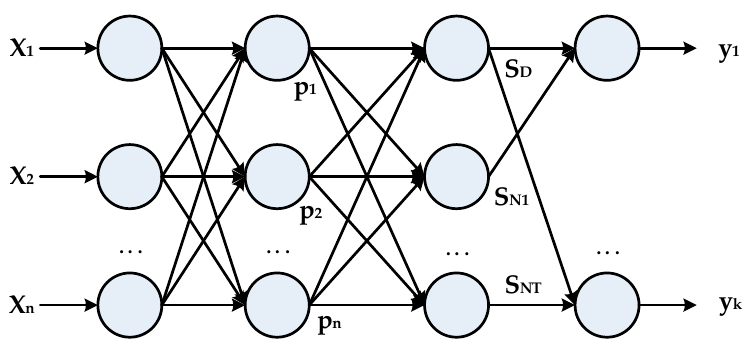
Figure 1. The structure of the general regression neural network (GRNN).